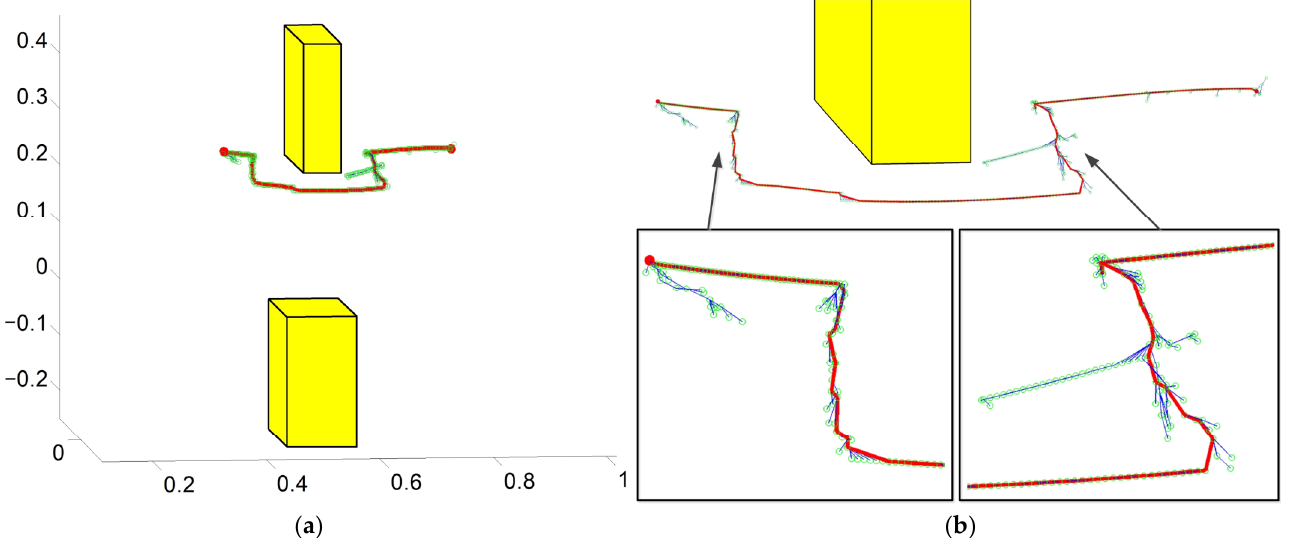
Figure 5. Path of the dual redundant manipulator in the task space: ( a ) global view; ( b ) partial enlarged view.